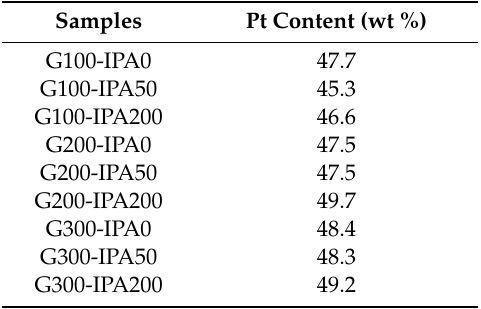
Table 1. Pt content (wt %) of the prepared Pt / C catalysts (estimated from